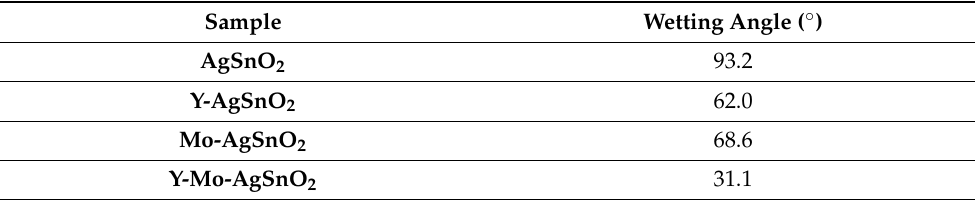
Table 8. Wetting angles.